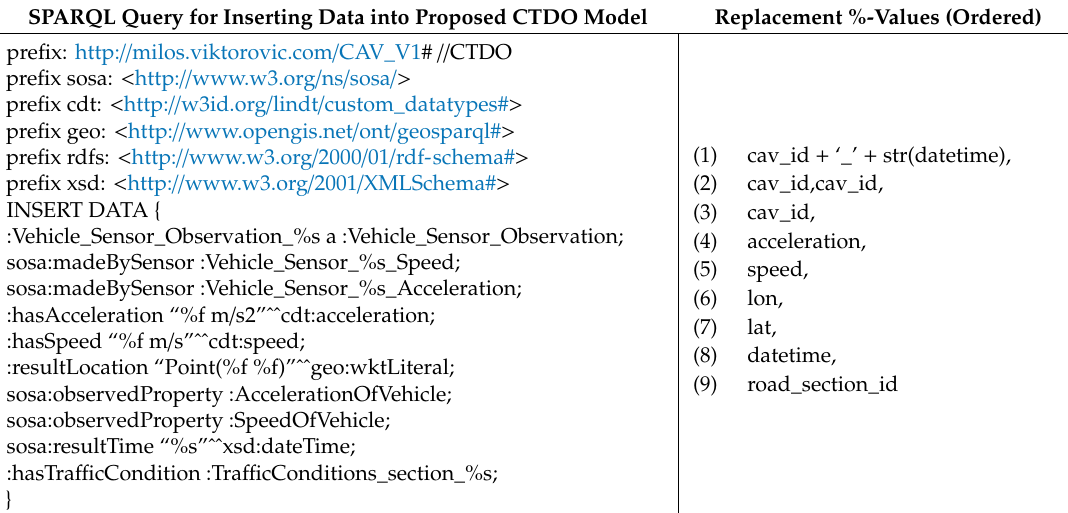
Table 1. SPARQL query for data insert into Connected Tra ffi c Data Ontology (CTDO) model. SPARQL Query for Inserting Data into Proposed CTDO Model Replacement %-Values (Ordered)